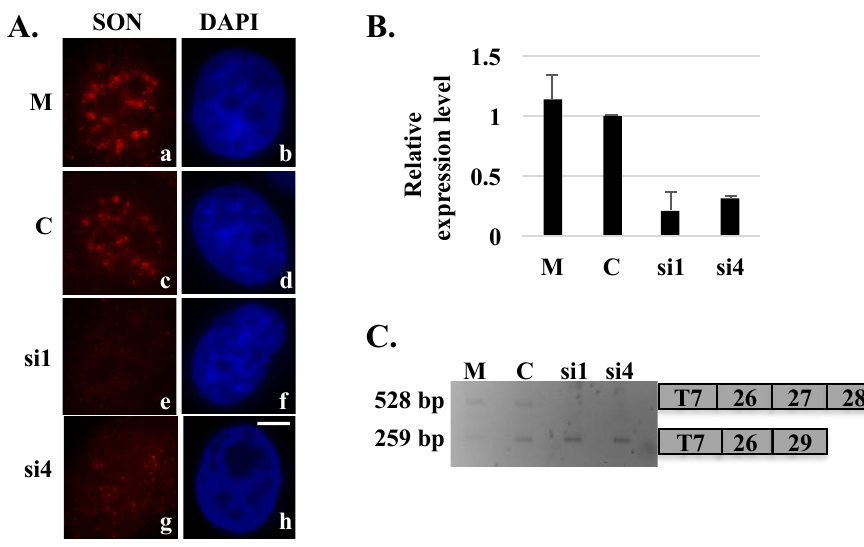
Figure 2. Skipping of exons 27 and 28 of the HDAC6 reporter minigene in SON-depleted cells. HeLa cells transiently transfected with HDAC6 reporter plasmid and treated with mock (M), control (C) or SON siRNA duplexes were either processed for immunofluorescence ( A ) or harvested to perform qRT-PCR ( B ) to show SON depletion. Cells treated with SON siRNAs and immunolabeled with anti-SON antibodies in ( A ) do not show SON labeling in nuclear speckles ( e and g ) when compared to mock treated ( a ) or control siRNA-treated ( c ) cells. DNA was stained with DAPI ( b , d , f and h ). Scale bar = 5 µm. qRT-PCR in ( B